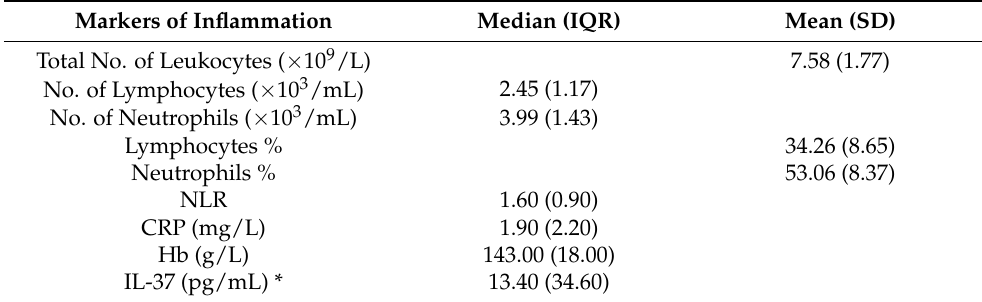
Table 1. Markers of inflammation.